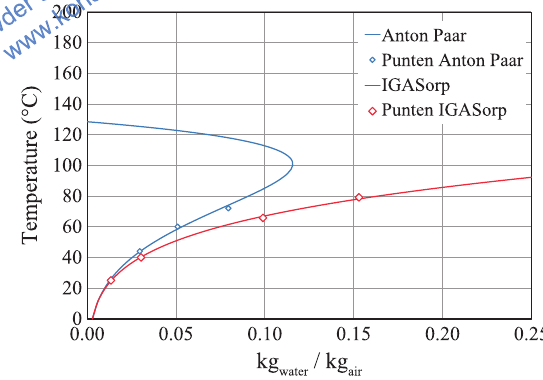
Fig. 8 Mollier diagram of the citric acid monohydrate material derived from the sticky points obtained via the Anton Paar Rheometer and the DVS system (linear